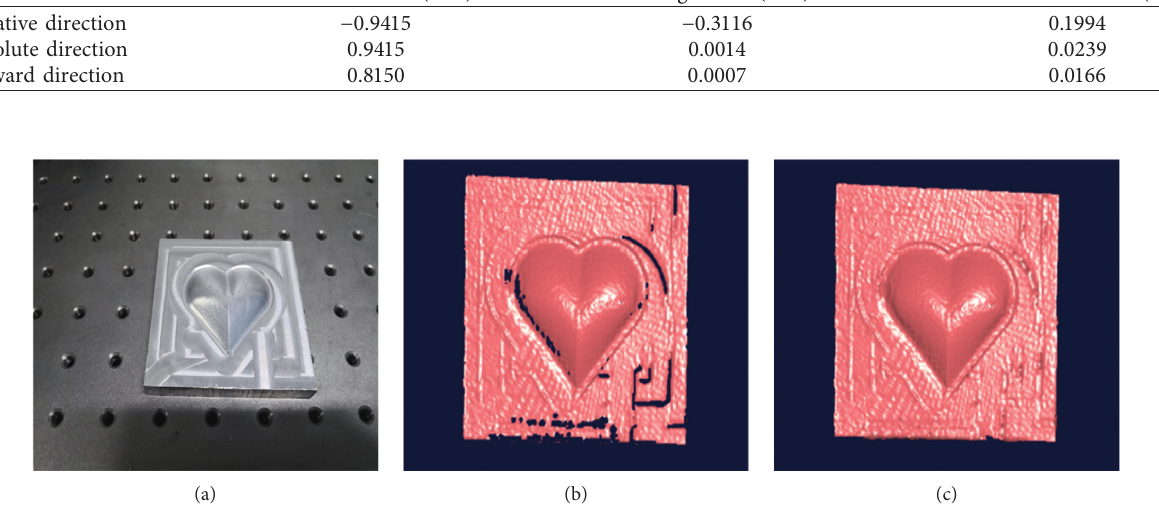
Figure 16: 3D point cloud of the depth map with reflection coefficient from 0.75 to 0.90: (a) measured metal object; (b) traditional ADFP method; (c) our